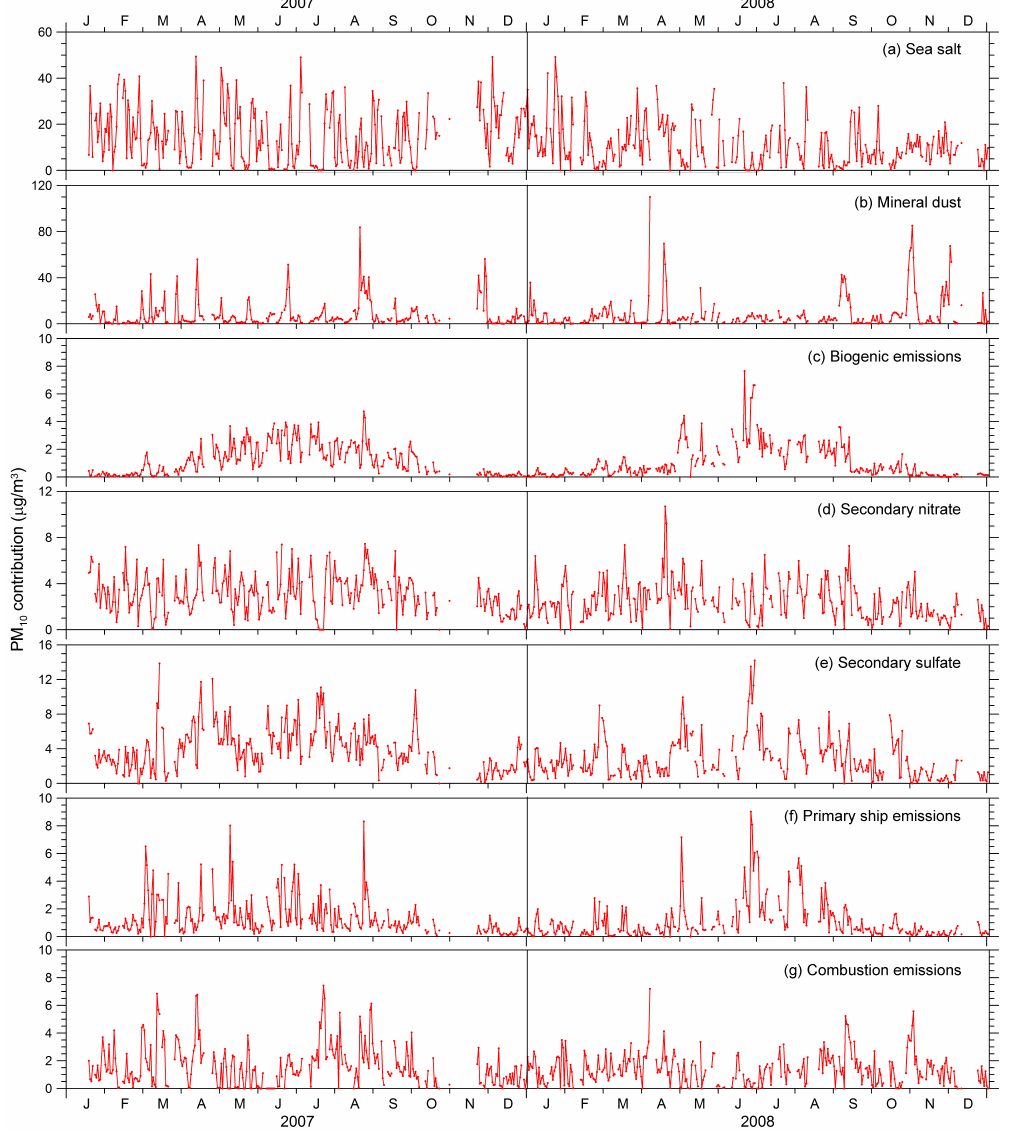
Figure 4. Temporal evolution of the PM 10 contributions from the identified sources. Table 2. Elemental ratios for the sea-salt